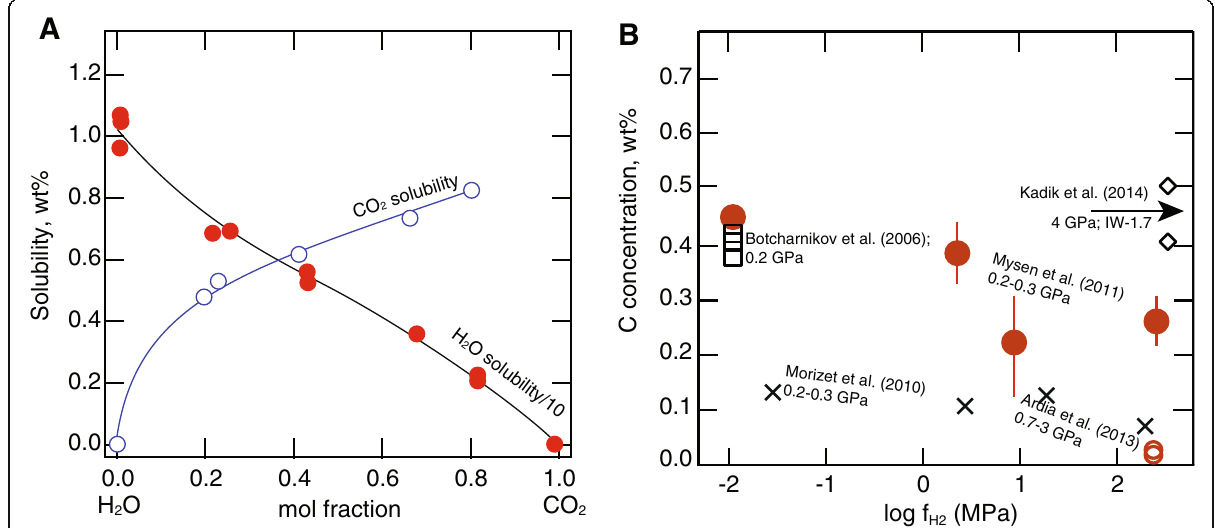
Fig. 2 Solubility of COH volatiles in silicate melts at high temperature and pressure. a Solubility under oxidizing conditions in ultrapotassic melts at 500 MPa and 1250 °C (data from (Behrens et al. 2009)). b Solubility of reduced C-species, shown as C, as a function of hydrogen fugacity at pressures or in pressure ranges indicated on individual curves (data from Botcharnikov et al. 2006; Morizet et al. 2010; Mysen et al. 2011; Ardia et al. 2013; Kadik et al.